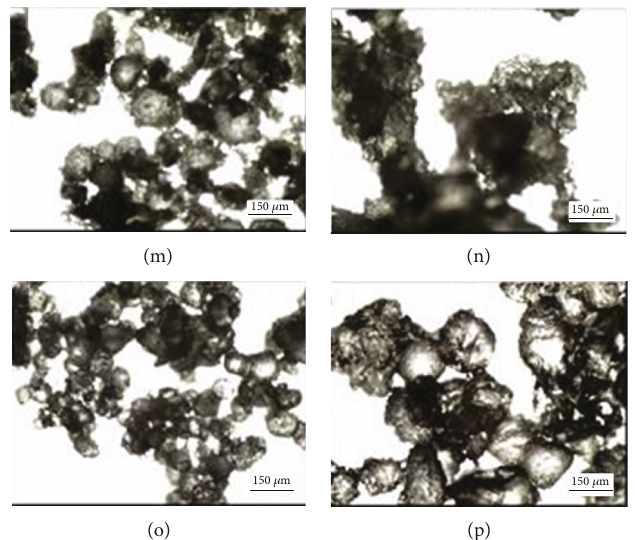
Figure 1: Surface morphology of samples 1-16 in Table 2.